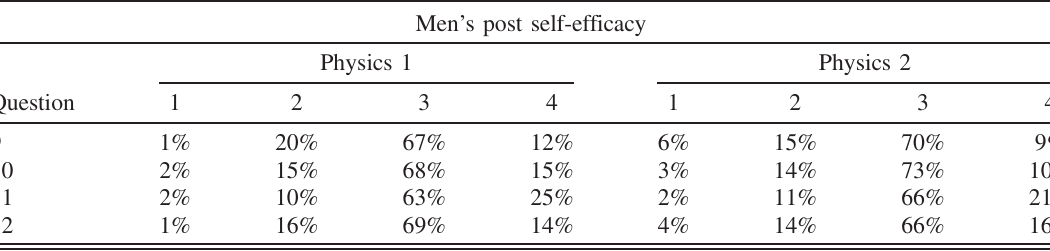
TABLE V. Percentages of men who answered each self-efficacy question by the options they selected with 1 being the low value (NO!) and 4 being the high value (YES!). The rating scale for the self-efficacy questions was: NO! no yes